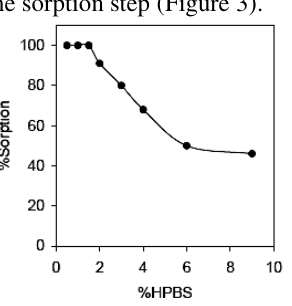
Figure 2 . Capacity of AC for the adsorption Figure 3 . Effect of pH on the